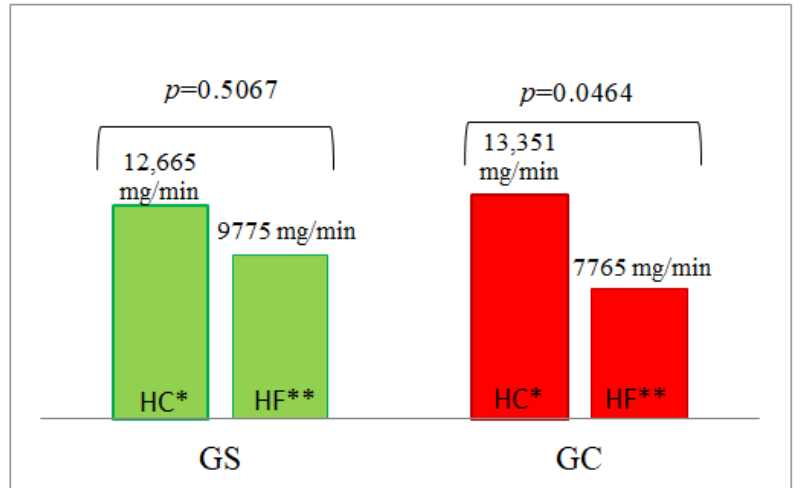
Figure 6. The AUC of glucose oxidation in the G S and G C groups after HC and HF meals. The results are presented as the mean values. * difference between the G S (obese/overweight) and G C (normal body weight) groups after HC meal (high-carbohydrate meal ( p = 0.3558)); ** difference between the G S and G C groups after HF meal (high-fat meal ( p = 0.2088)).